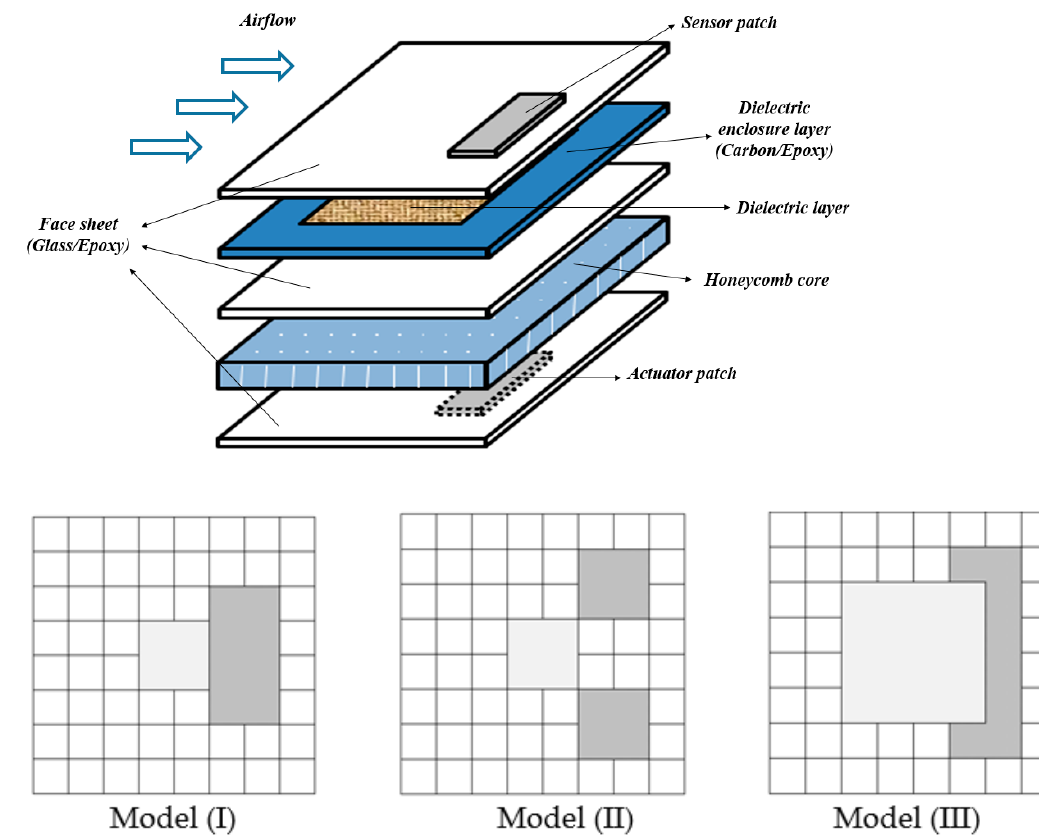
Figure 9. Three cases with various dielectric portion and piezoelectric patches. Firstly, the thermal variation ( T Δ ) is selected as 0 and 30, and the aerodynamic load is chosen as 1200 λ= in Figure 10a. The result shows that the flutter motion of the model can be suppressed faster in low temperature conditions. On the other hand, the pressures ( λ ) in Figure 10b are chosen as 1200 and 1600 without considering thermal effect. In this case, flutter suppression is more difficult with high pressure loads. It can be seen that the oscillation of the structure is reduced more quickly with low temperature and aerody- namic pressure. Additionally, the results of the bold lines are dealt with in the same con- ditions as in both Figure 10a,b.